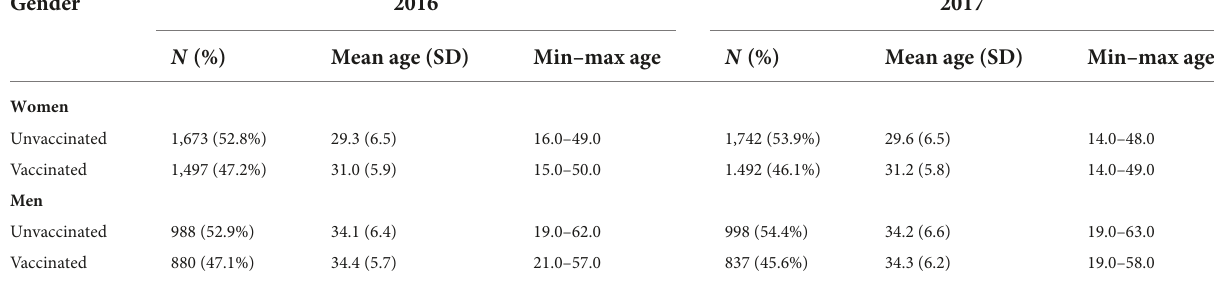
TABLE 1 Age of women and men according to their vaccination status and the year of childbirth/beginning of paternity